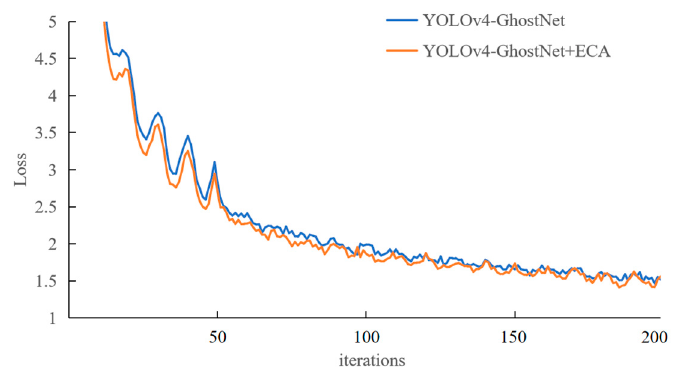
Figure 10. Network training loss